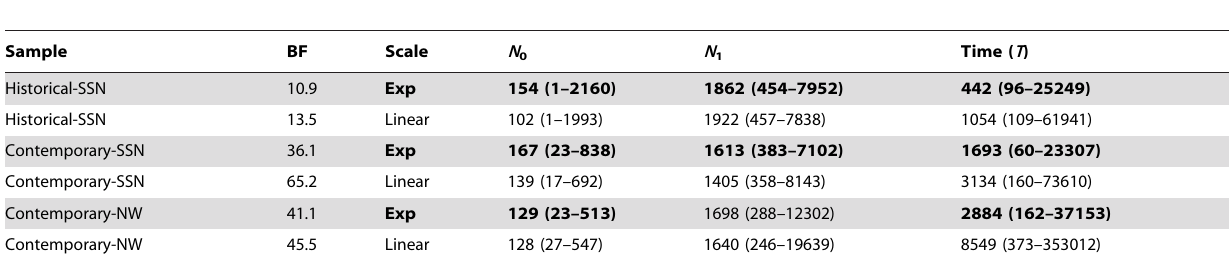
Table 4. The mode and 90% highest posterior density (in parentheses) of the posterior distributions for the Storz and Beaumont [67]